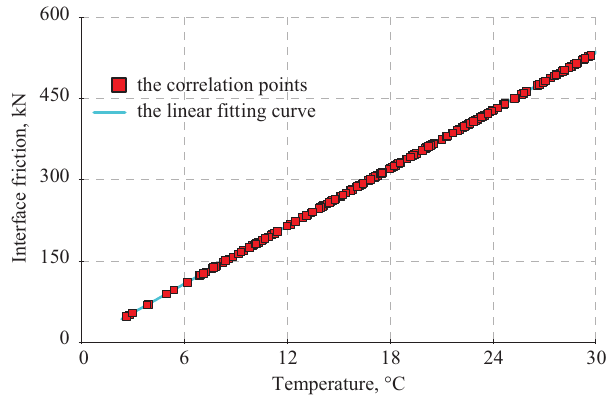
Figure 13. The correlation between friction and